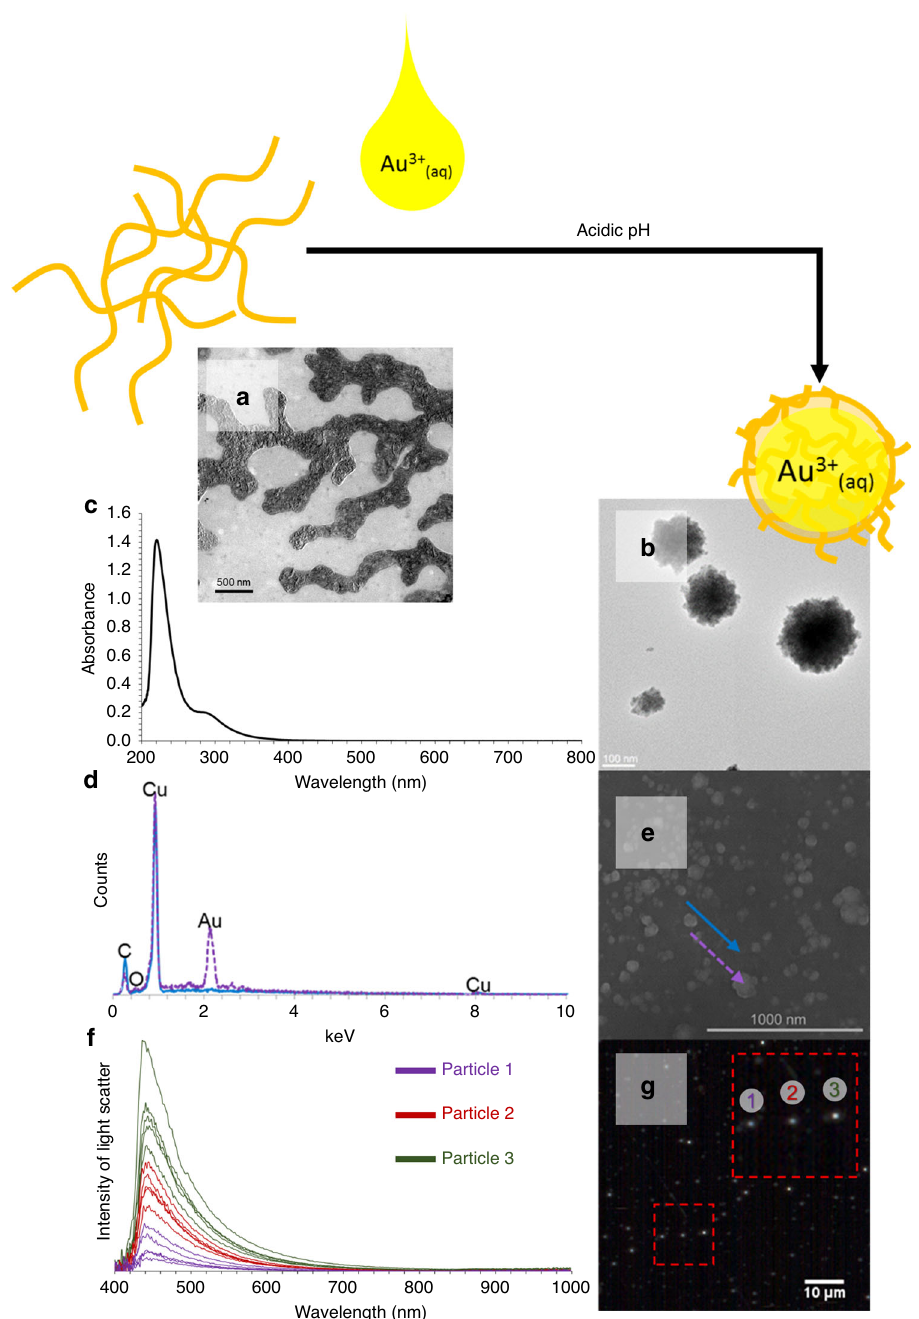
Fig. 1 Characterization of ionic Au-PEG delivery vehicle. Representative transmission electron microscopy (TEM) images of ( a ) PEG and ( b ) ionic Au – PEG clusters. c UV – vis absorbance spectrum of ionic Au – PEG clusters (200 – 800 nm). d Electron dispersion spectrum of ionic – Au – PEG clusters (on